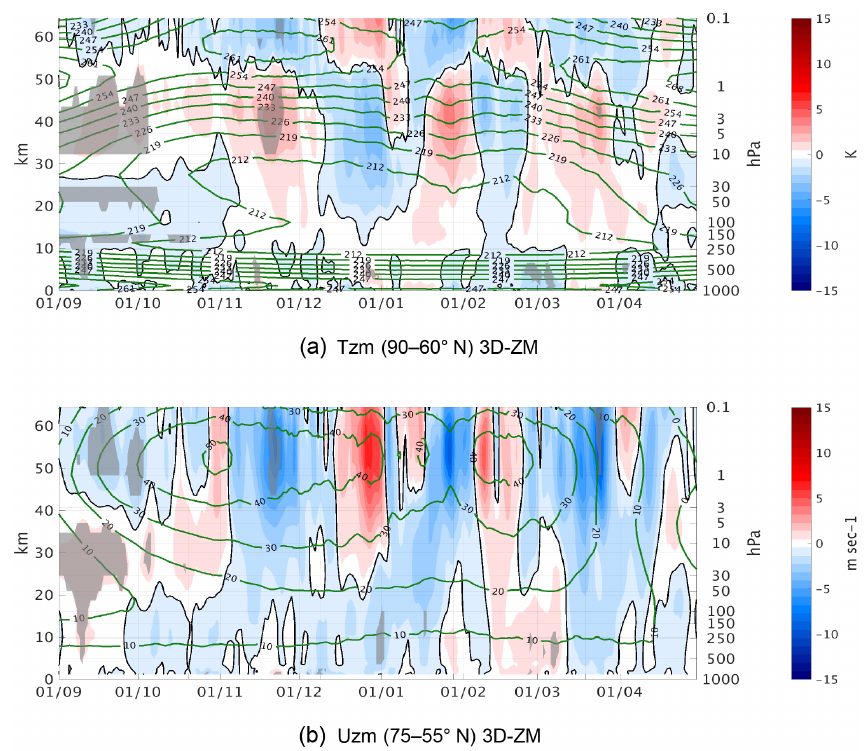
Figure 2. Height–time differences between the 3DO 3 and ZMO 3 run for all years for zonal mean temperature, zonal wind, EP flux divergence, and temperature zonal wave 1 amplitude (from top to bottom). The differences between the 3DO 3 and the ZMO 3 model runs are indicated by the colored contours; the climatology of the 3DO 3 run is shown by the green contours. Statistically significant areas are shown by gray shading.